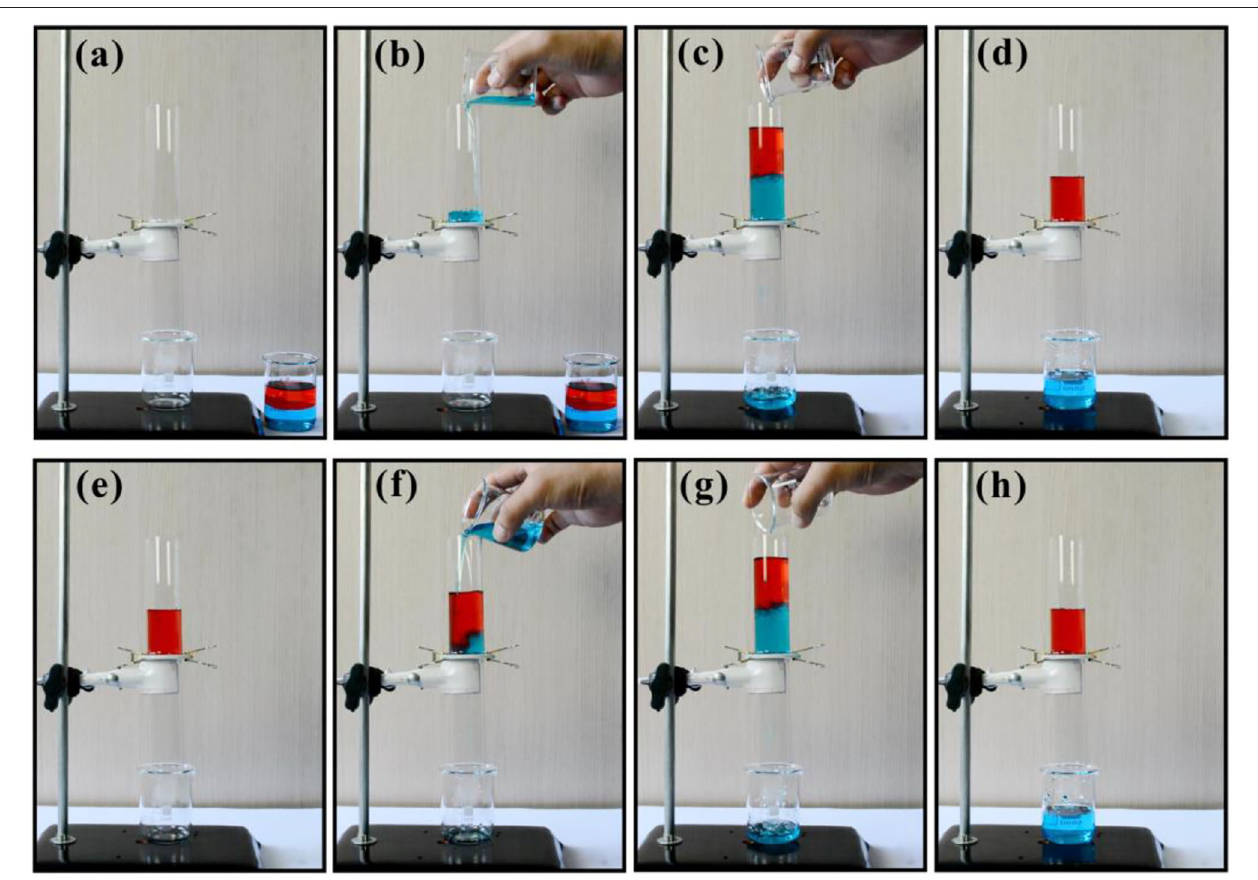
FIGURE 4 | Oil-water separation based on the femtosecond laser-induced porous underwater superoleophobic metal sheet. (a) Designed device before separation. (b) Pre-wetting the metal sheet with a little water. (c) Pouring the mixture of water (blue color) and oil (red color) into the separation device. (d) After separation. (e–h) Reactivating the separation process by adding new water into the device that just finished a cycle of oil-water separation.